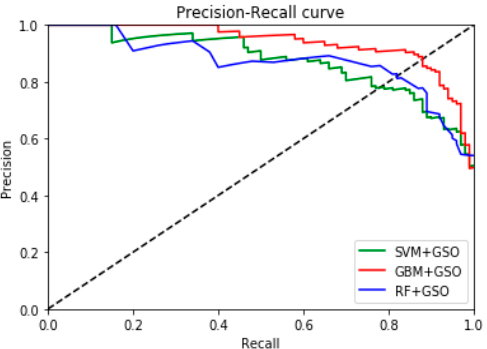
Figure 7. Comparison of the precision–recall curves space for the three-class classification.